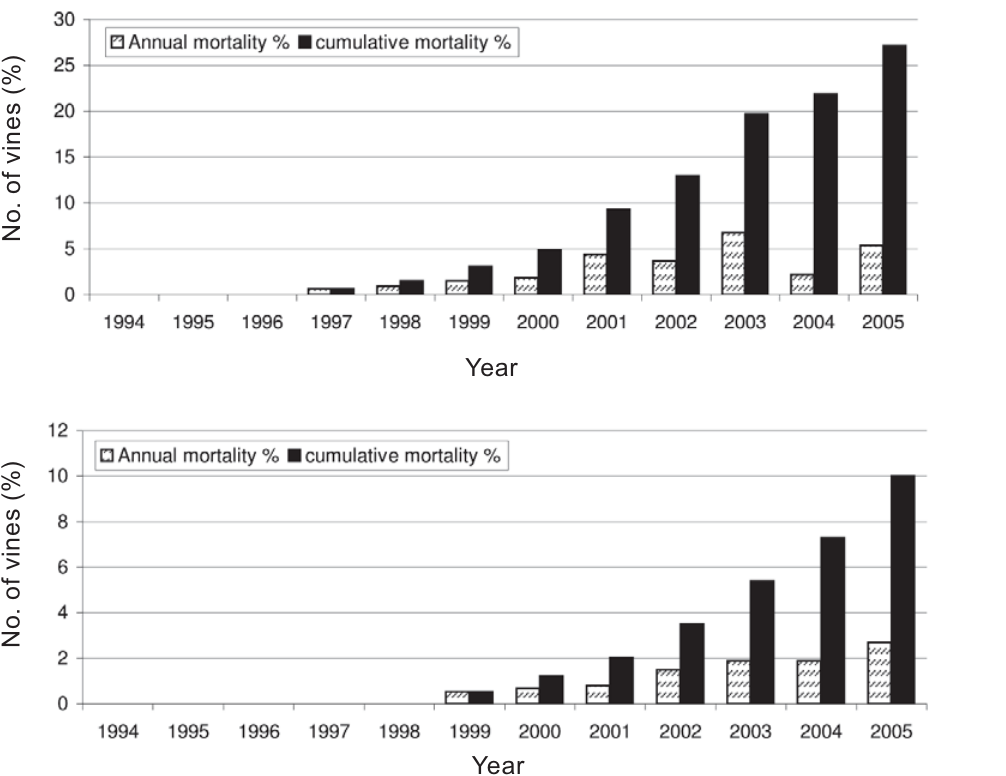
Fig. 1. Annual and cumulative mortality on vines affected with esca proper in the Controguerra (top) and Giuliano- va (bottom) vineyards.